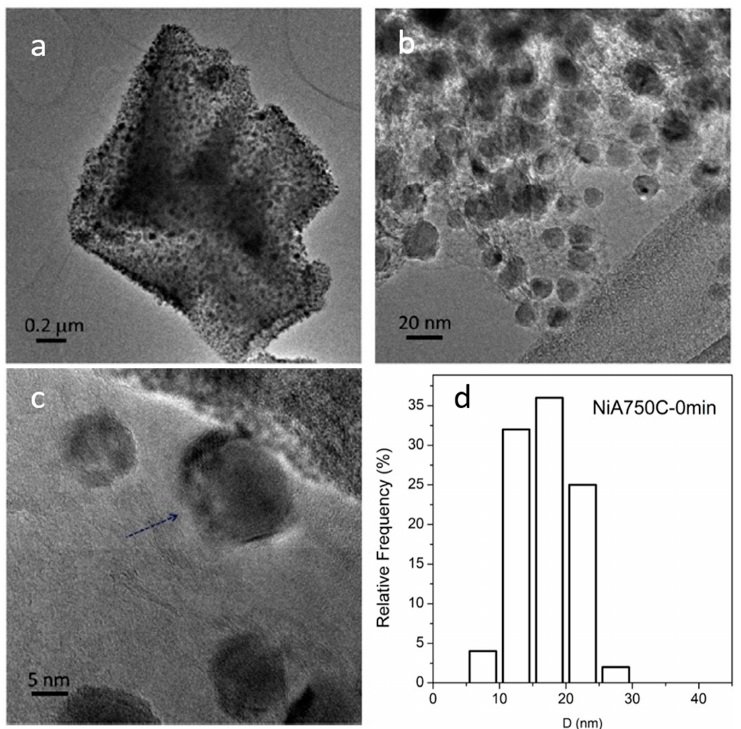
Figure 12. TEM ( a – c ) and HR-TEM ( d ) images collected of the NiA750C—0 min sample. Instrumental magnification: 8000×, 30,000×, 100,000×, and 400,000×. Reprinted in modified form from the work of [14] with permission from Elsevier. ( d ) Ni particle size distribution.